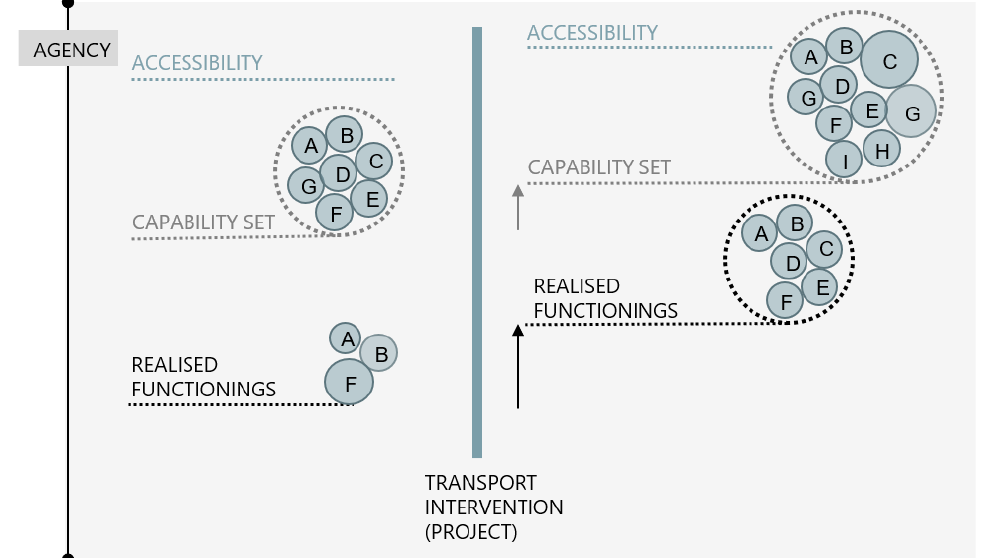
Figure 1. Potential changing functionings and capabilities in relation to a transport project (developing Ryan et al.,